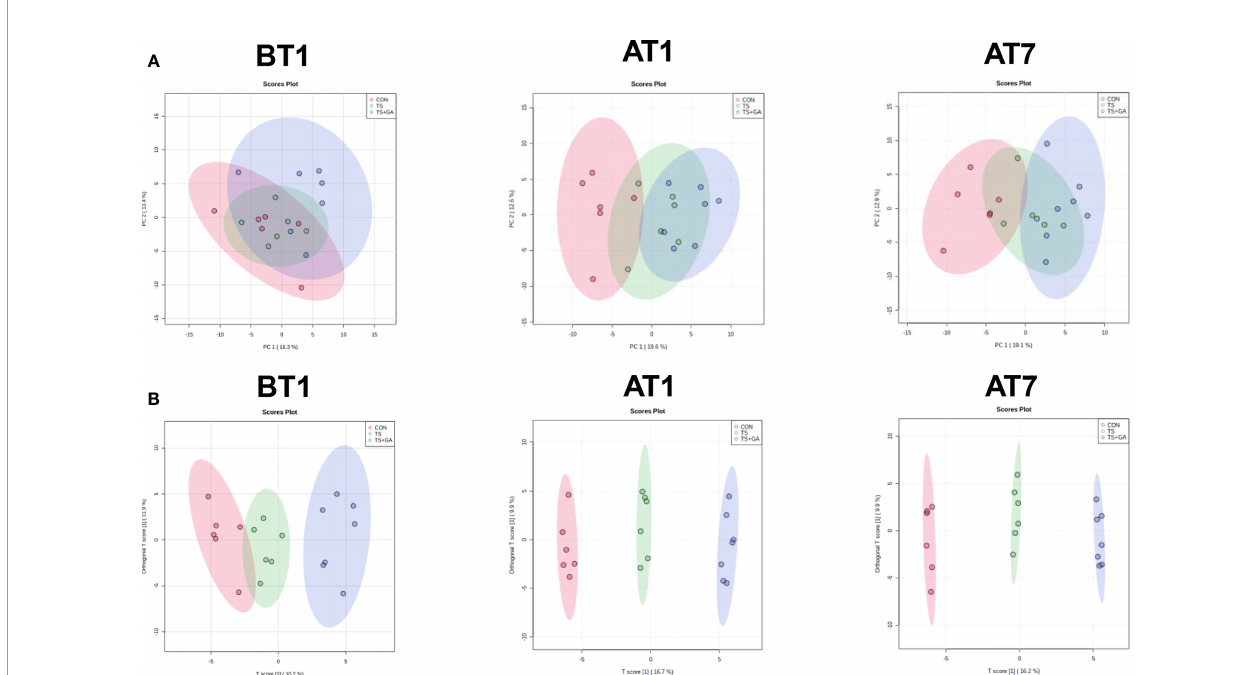
FIGURE 8 | Multivariate statistical analysis on BT1, AT1, and AT7 (n = 6 or 7). Score plots from the principal component analysis (PCA) model among three groups on BT1, AT1, and AT7 (A) . Score plots from the orthogonal partial least-squares discriminant analysis (OPLS-DA) model among three groups on BT1, AT1, and AT7 (B) . BT1, the 1st day before transportation; AT1, the 1st day after transportation; AT7, the 7th day after